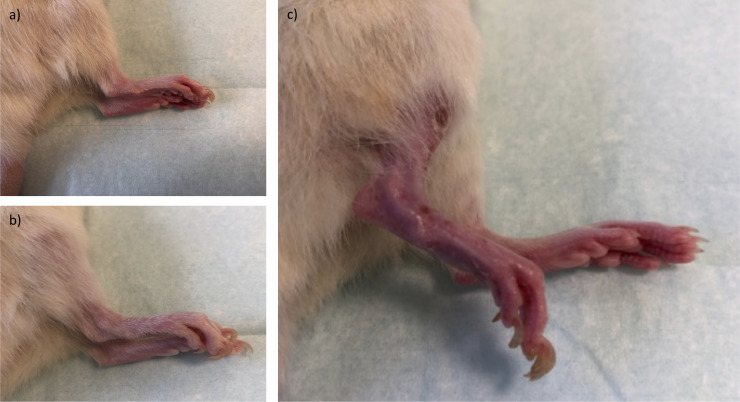
Hind limbs at POD 100.a+b) Iso and CsA group hind limbs did not present any clinical signs of inflammation or rejection. c) CR hind limb: Muscle and skin atrophy as well as hair loss is noted in comparison to native limb (background).